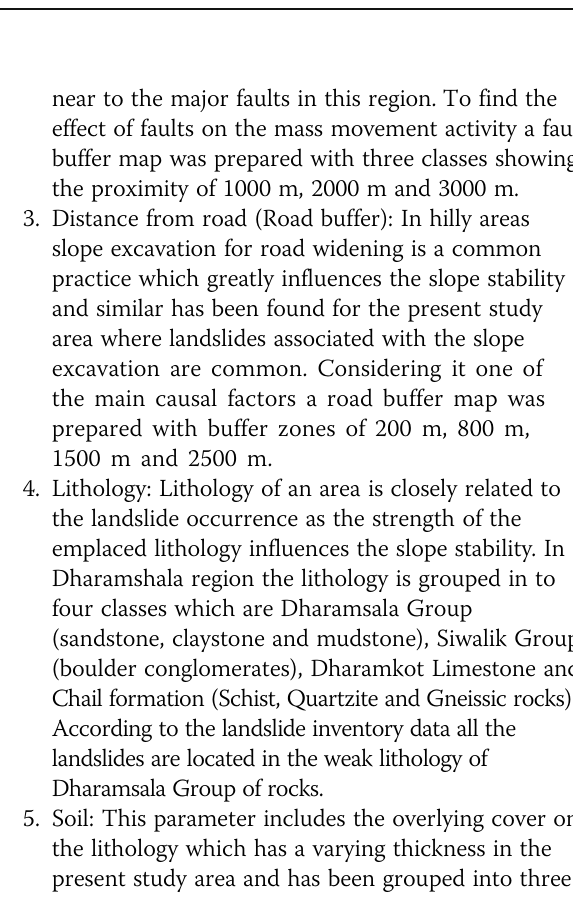
Fig. 4 Field photographs of few recent landslides in Dharamshala region a Vulnerable slope along Dharamshala - Mecleodganj main road b Chhola landslide along the Charan Khad c Bypass road landslide near Kotwali bazaar d Naddi landslide near Dal